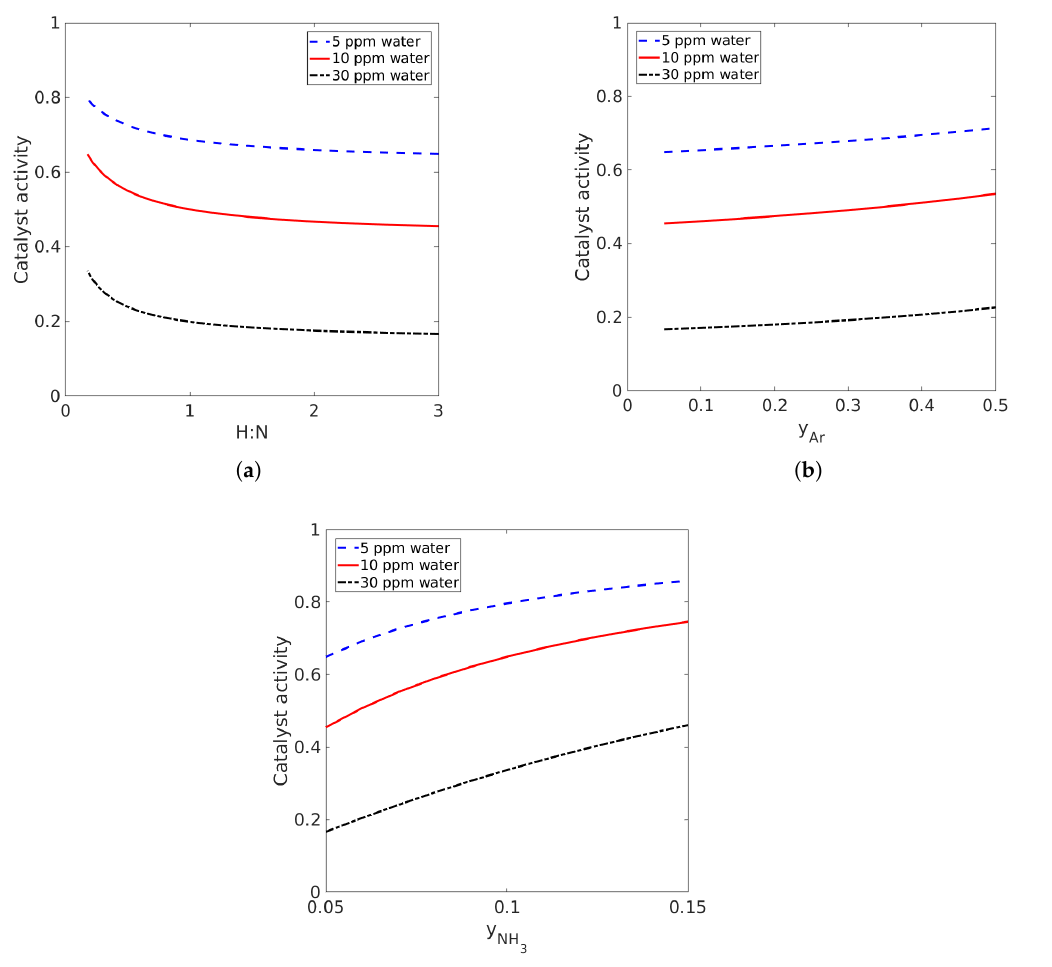
Figure 4. Catalyst activity for different gas compositions at P = 150 bar and T = 700 K. ( a ) y Ar = 0.05, = 0.05; ( b ) H:N = 3, y y NH 3